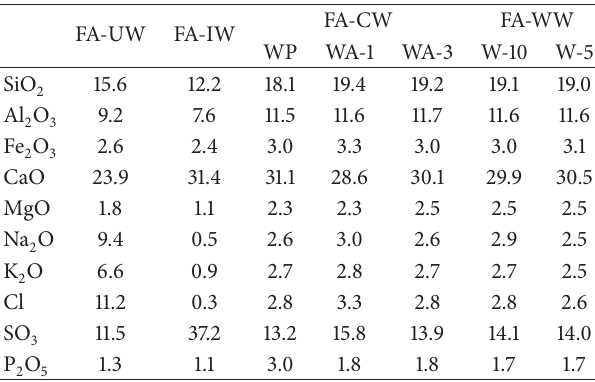
Table 2: Chemical composition of treated fly ashes (wt. %).